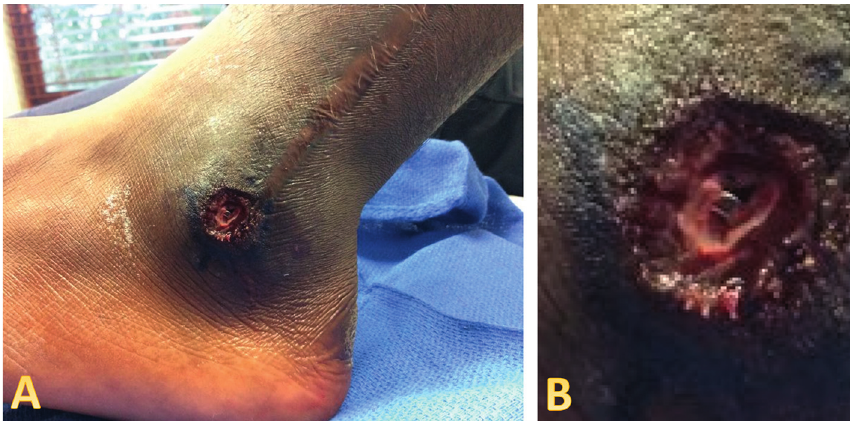
Figure 3: Mohs intraoperative imaging. After debulking, a metallic foreign body is present centrally (a), most consistent with a displaced orthopedic surgical screw. A closer view is appreciated